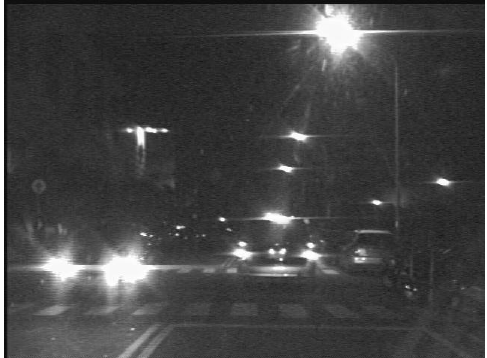
Figure 3. A sample grayscale nighttime road